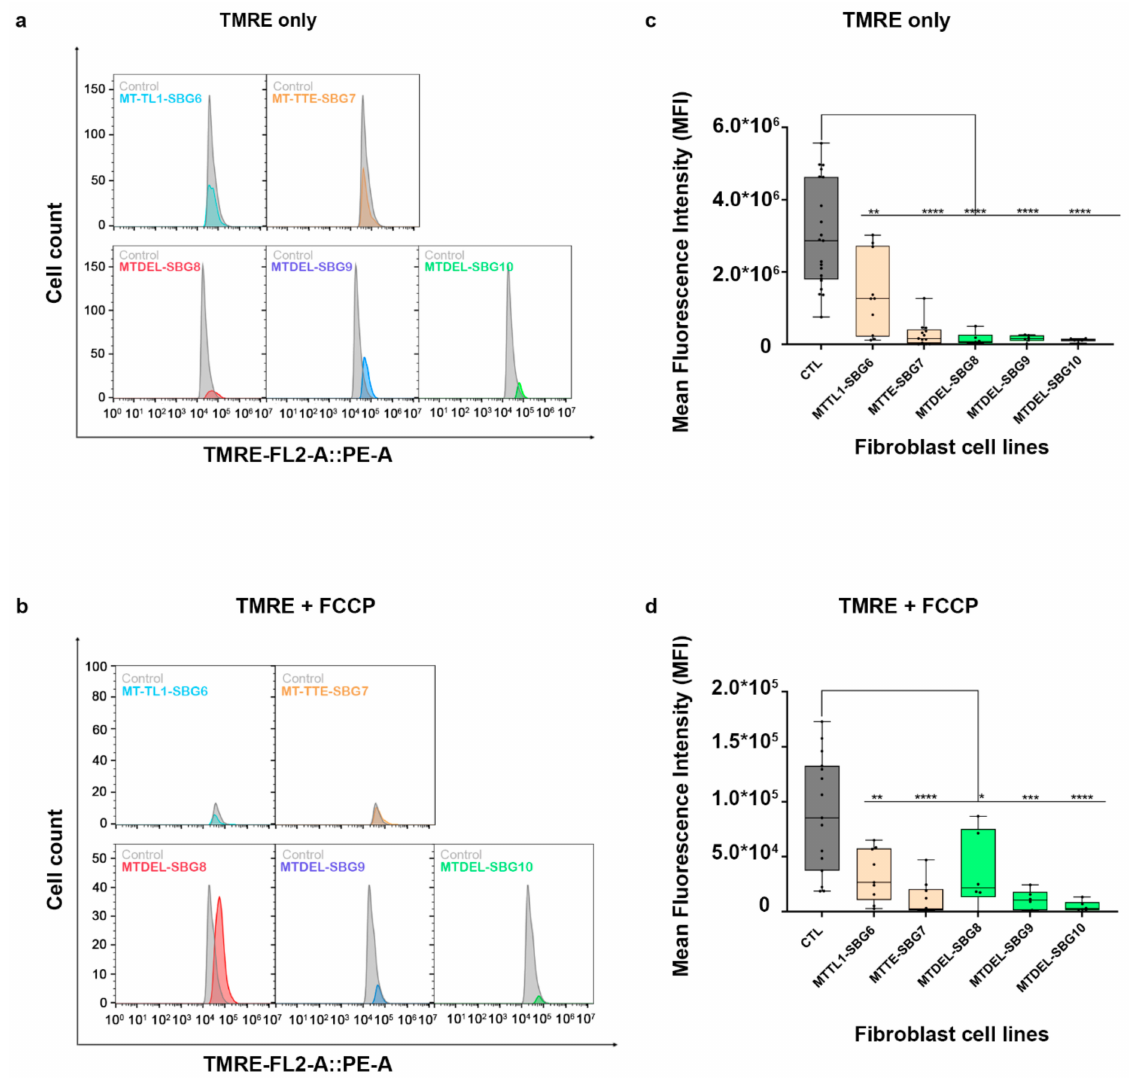
Figure 14. Mitochondrial membrane potential (MMP) analysis of BJ-FB diseased fibroblast cell lines. Using flow cytometry, along with membrane-potential sensitive dye (TMRE), MMP was evaluated. Representative flow cytometry histogram of five fibroblasts (SBG6–10 and Control BJ) ( a ) stained with TMRE only; ( b ) stained with TMRE after treatment with FCCP. Mean fluorescence intensity (MFI) was calculated based on three independent runs and are shown for (Control BJ-FB in grey; SBG6-FB (m.3243A>G) and SBG7-FB (m.14739G>A) in tan; SBG8-FB (10676 ∆ 14868), SBG9-FB (7342 ∆ 9916), and SBG10-FB (10167 ∆ 15568) in green) all samples ( c ) stained with TMRE only; ( d ) stained with TMRE after treatment with FCCP. * p < 0.05, ** p < 0.01, *** p < 0.001, **** p <